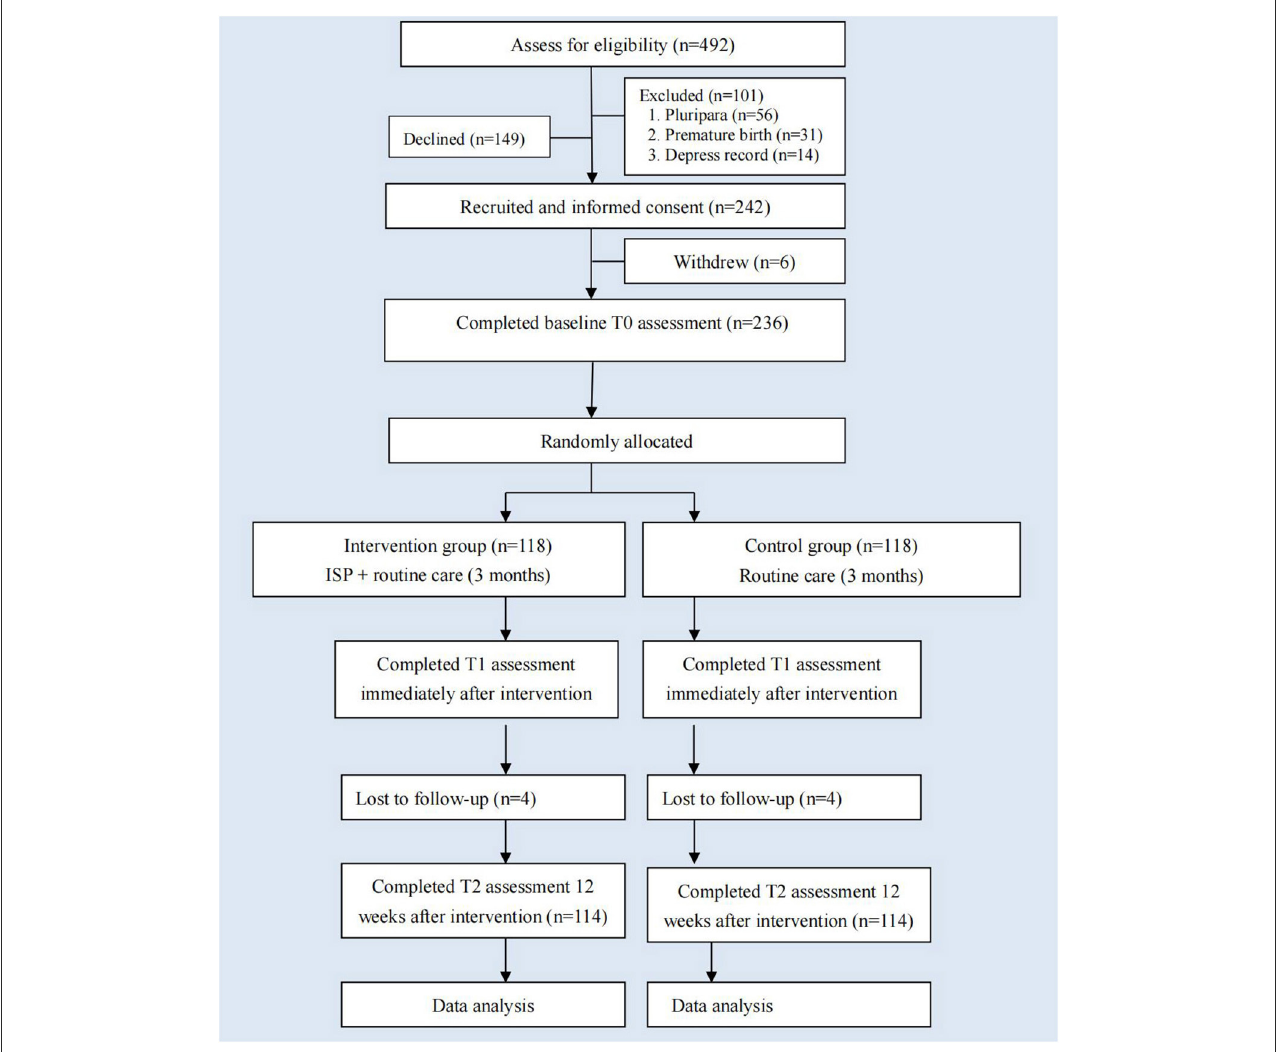
FIGURE1 Consolidated Standard of Reporting Trials (CONSORT) flowchart in the research. SICS, the Self-efficacy in Infant Care Scale; EPDS, Edinburgh Postnatal Depression Scale; PSSS, Postnatal Social Support Scale.